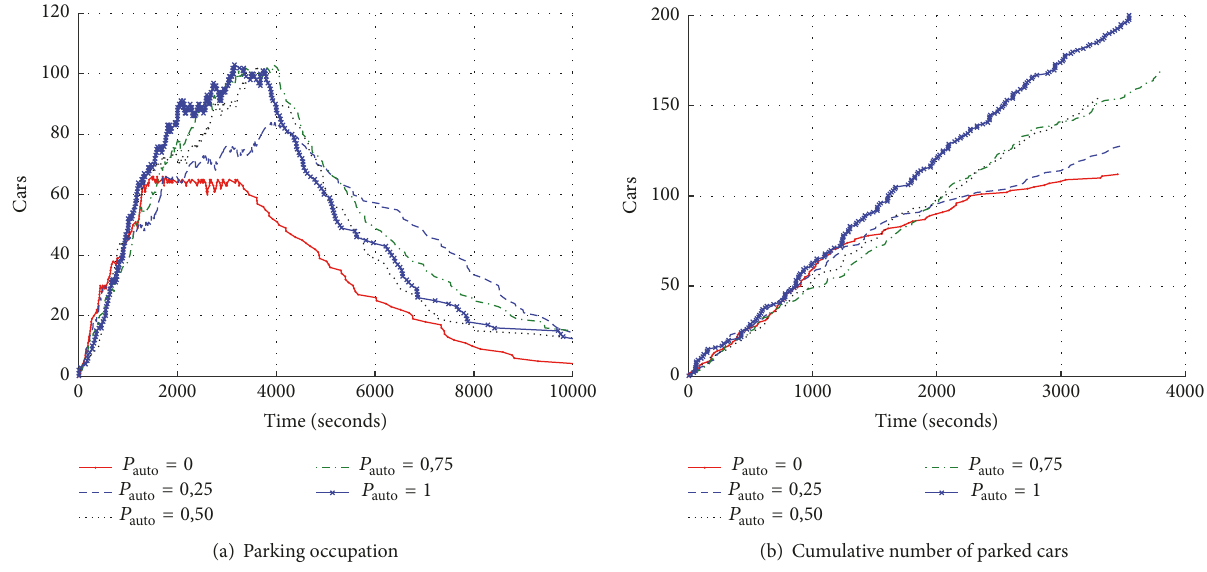
Figure 7: Dynamics of the parking occupation in terms of (a) number of cars during the simulation and (b) its cumulative value.